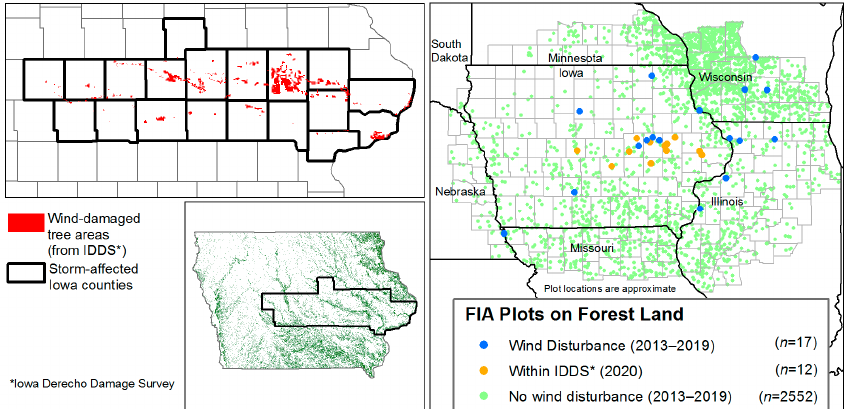
Figure 2. Iowa Derecho Damage Survey (IDDS) polygons within a 19-county area impacted by the 2020 Midwest Derecho ( top left ); NLCD2016 tree canopy cover in Iowa ( bottom left ); and FIA forest plots within a 221-county region, Iowa and adjacent states, USA ( right ). Plots were measured during 2013–2019 and depicted FIA plot locations are approximate.